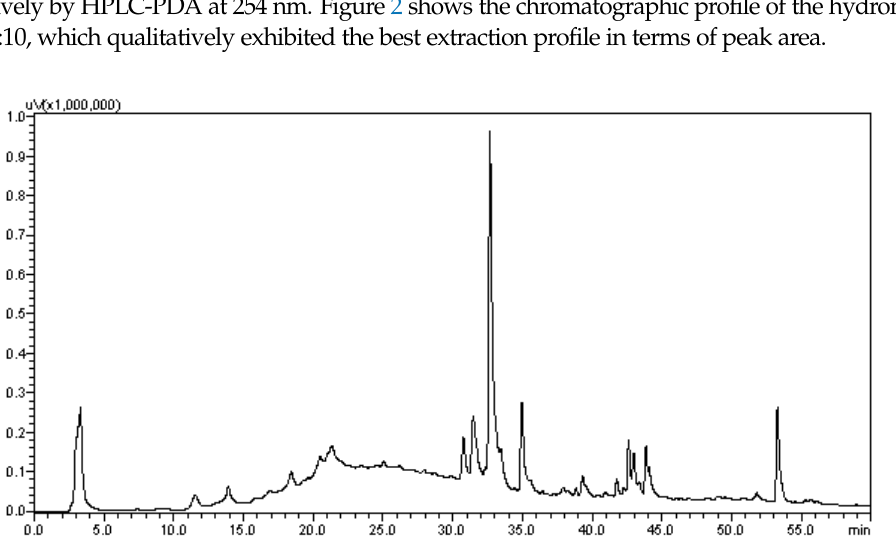
Figure 3. First-order spectrum of direct flow injection analysis (FIA-ESI-IT-MS) obtained in the negative mode for EHVG. (  ) Fragments of the chemical compounds identified. The fourteen compounds identified by flow injection analysis (FIA-ESI-IT-MS) are depicted in Table 2. It is possible to observe a predominance of anthraquinones, flavonoids, and Vismione D. Table 2. Compounds identified by MS n in Vismia guianensis extract. Number